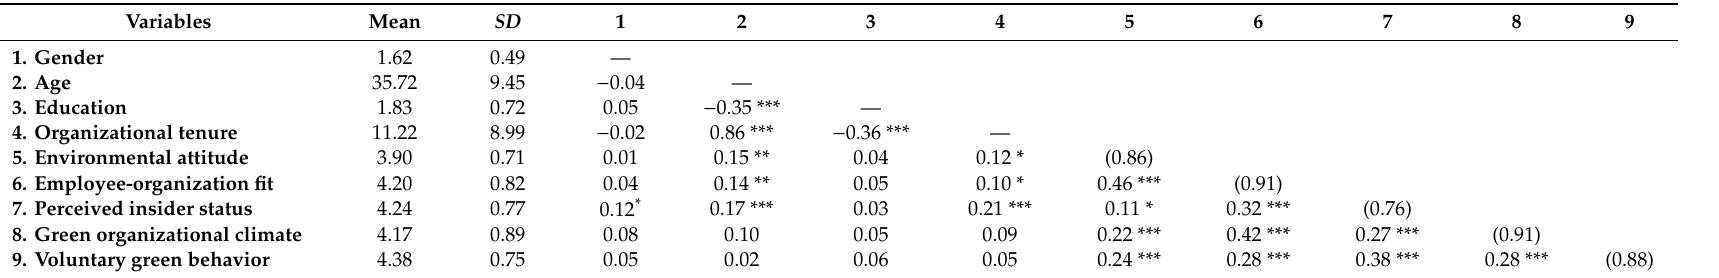
Table 2. Means, standard deviations, correlations, and reliabilities of studied variables.